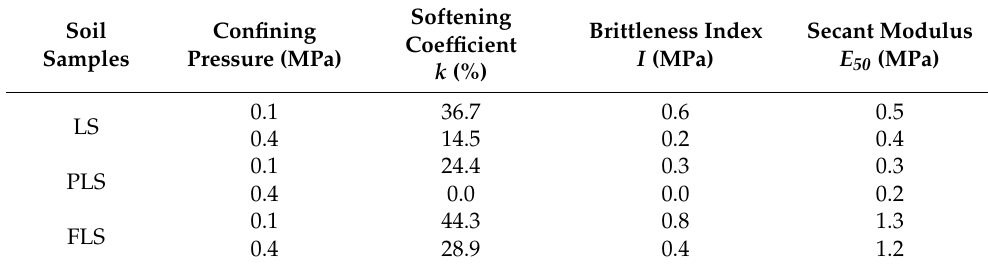
Table 6. Failure characteristics of modified